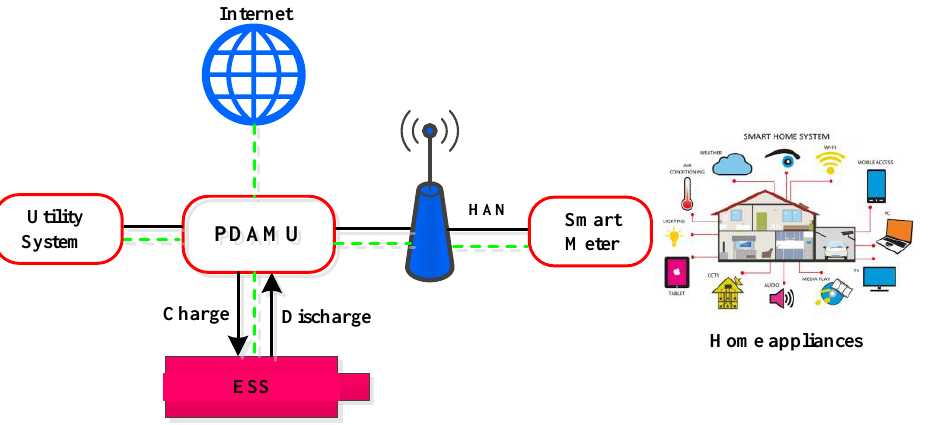
Figure 2. Advanced smart metering architecture in the smart grid